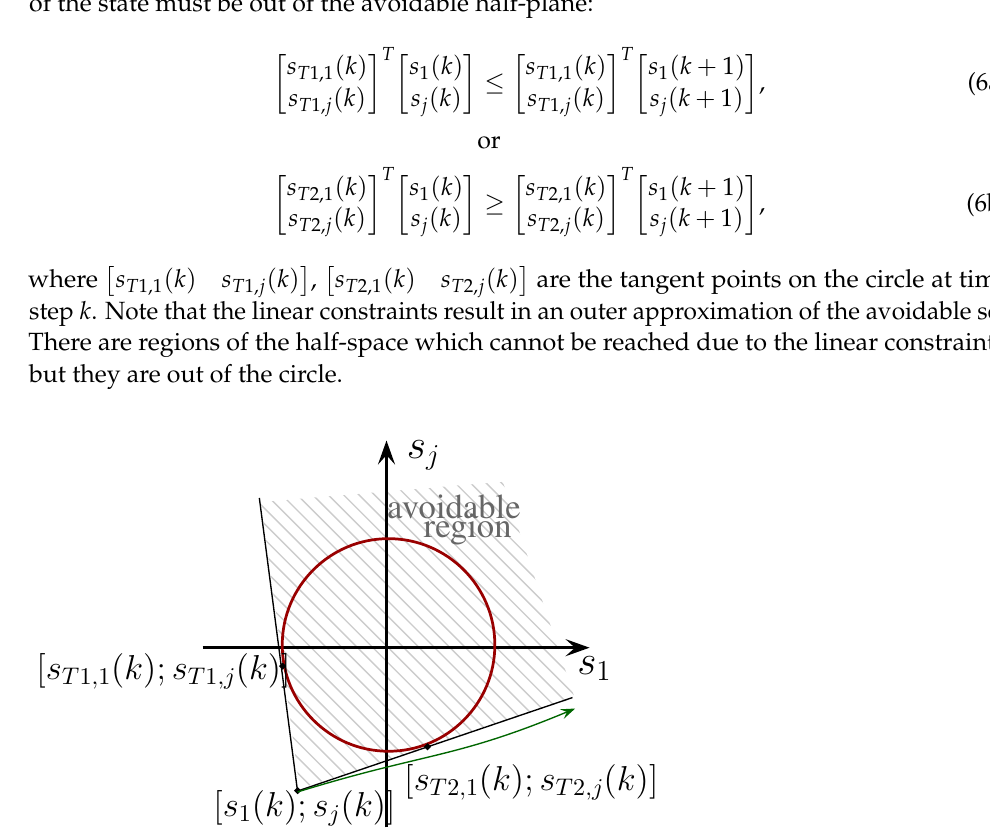
Figure 2. Illustration of constraint